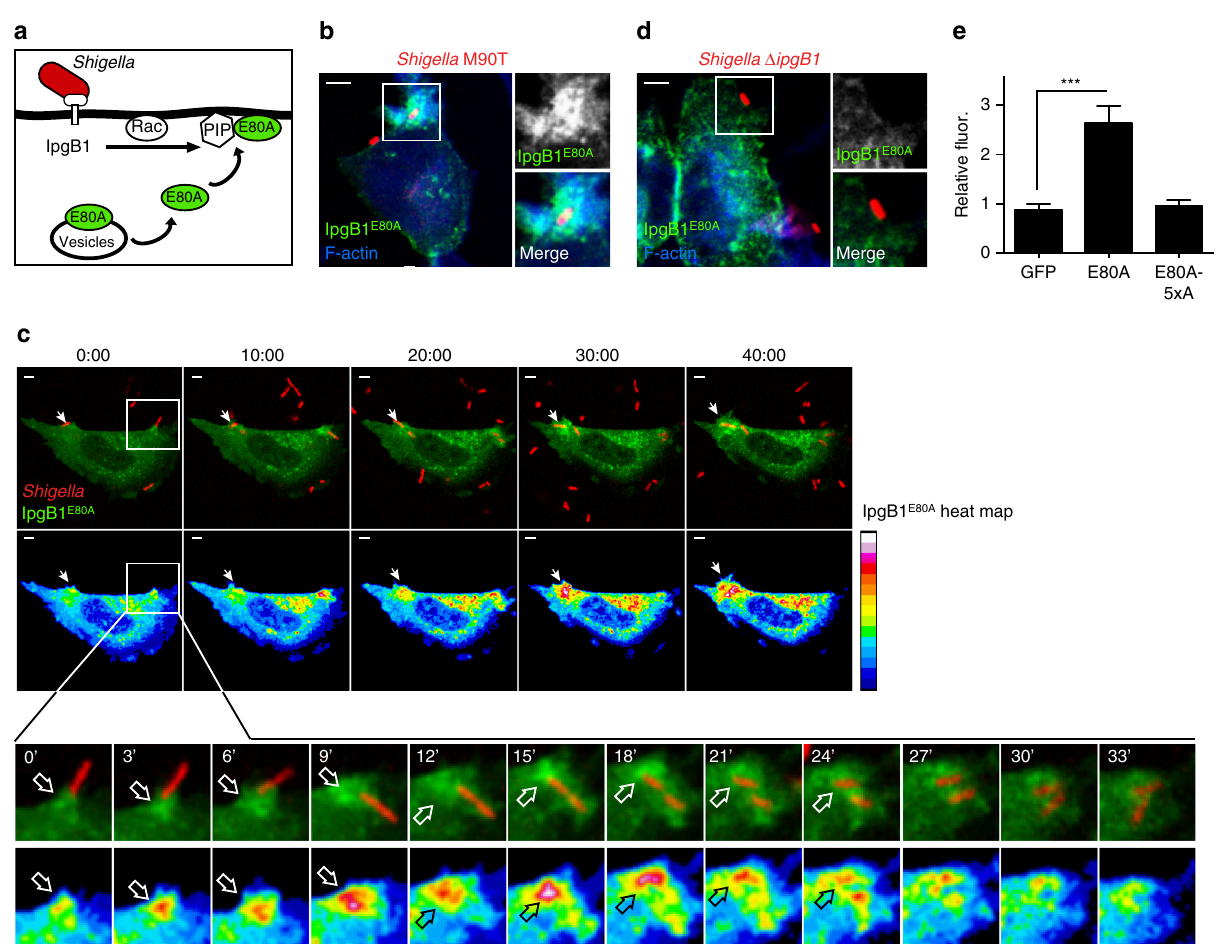
Fig. 8 IpgB1 is recruited to site of Shigella invasion. a Cartoon diagram of the strategy to monitor the IpgB1 subcellular localization during Shigella infection. mCherry-expressing Shigella inject IpgB1 into host cells expressing the activity probe EGFP-IpgB1 E80A . b Fluorescent micrograph of a HeLa cell expressing EGFP-IpgB1 E80A ( green ) and infected with mCherry-expressing wild-type Shigella M90T ( red ). AlexaFluor 350 Phalloidin is used to visualize the F-actin ( blue ) architecture. The boxed region contains the phagocytic cup and is in enlarged ×2 depicting the EGFP-IpgB1 E80A signal ( top ) and the merged image ( bottom ). Scale bar is 5 μ m. c Time-lapse fl uorescent microscopy of Shigella -mCherry ( red ) infecting an EGFP-IpgB1 E80A ( green ) expressing HeLa cell ( top ). Heat map of the pixel intensity of EGFP-IpgB1 E80A at the indicated time points. Scale bar for the heat map is shown to the right ( bottom ). Scale bar is 5 μ m. d Fluorescent micrograph of a HeLa cell expressing EGFP-IpgB1 E80A ( green ) and infected with mCherry-expressing Shigella Δ ipgb1 ( red ). Figures are displayed as in ( b ). e Quanti fi cation of recruitment of lipid probes. Values reported as a fold increase of fl uorescent signal in the phagocytic cup over